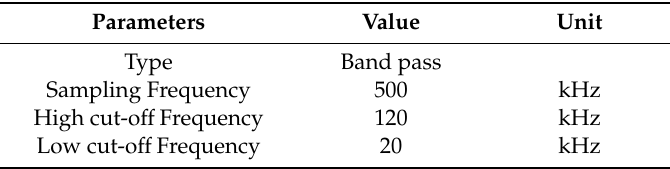
Table 3. Parameters of the digital Butterworth